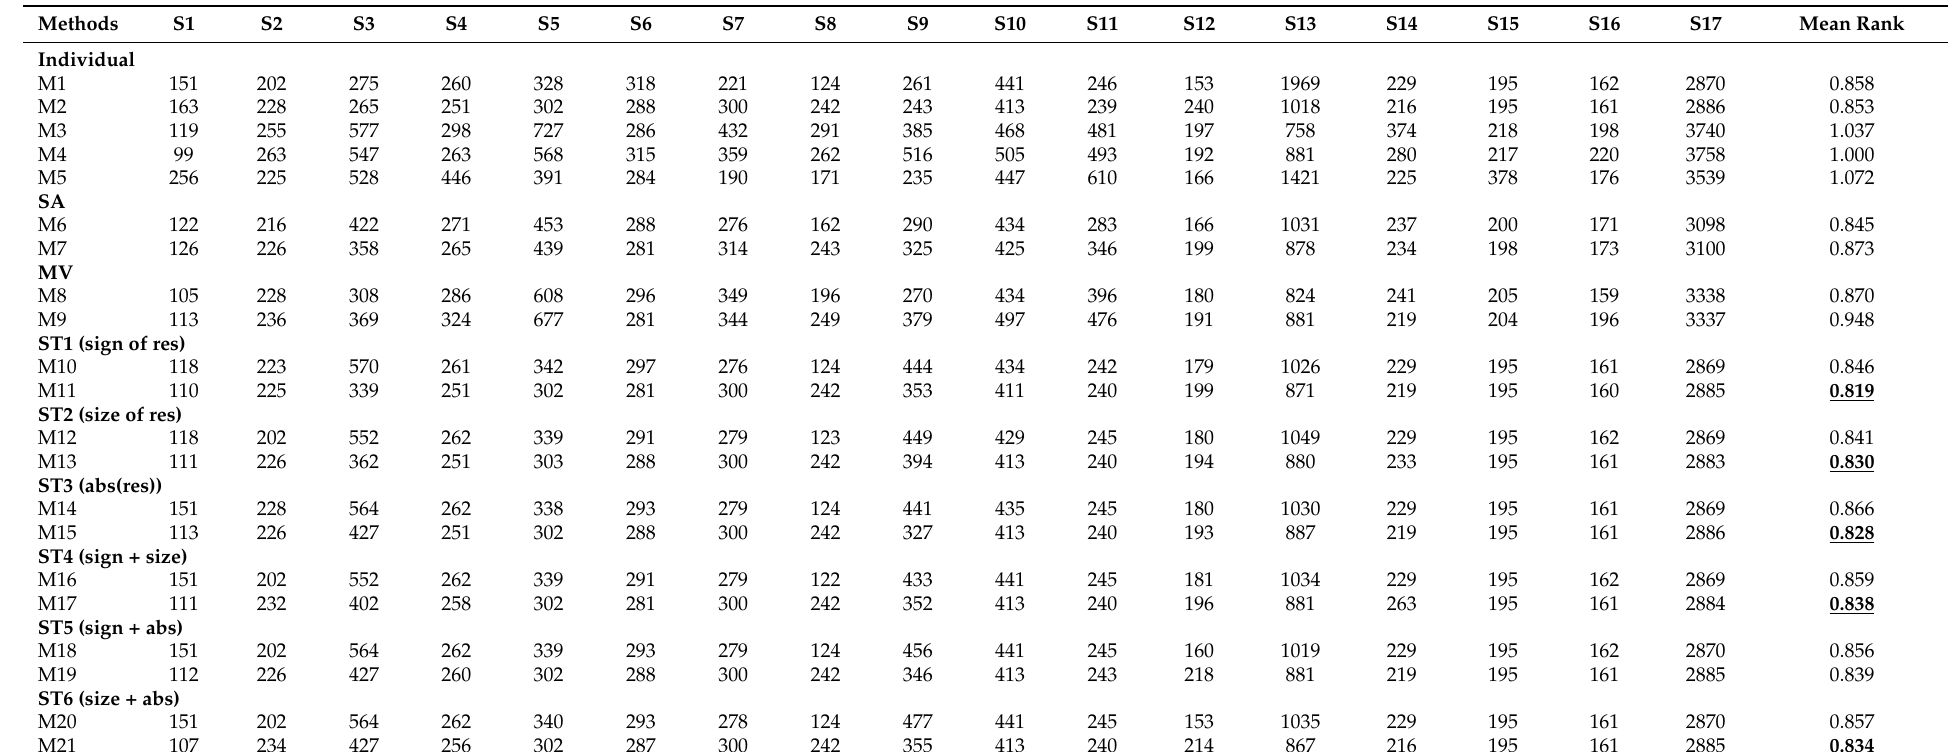
Table 13. RMSE ( × 10 4 ) for out-of-sample in tourism demand volatility